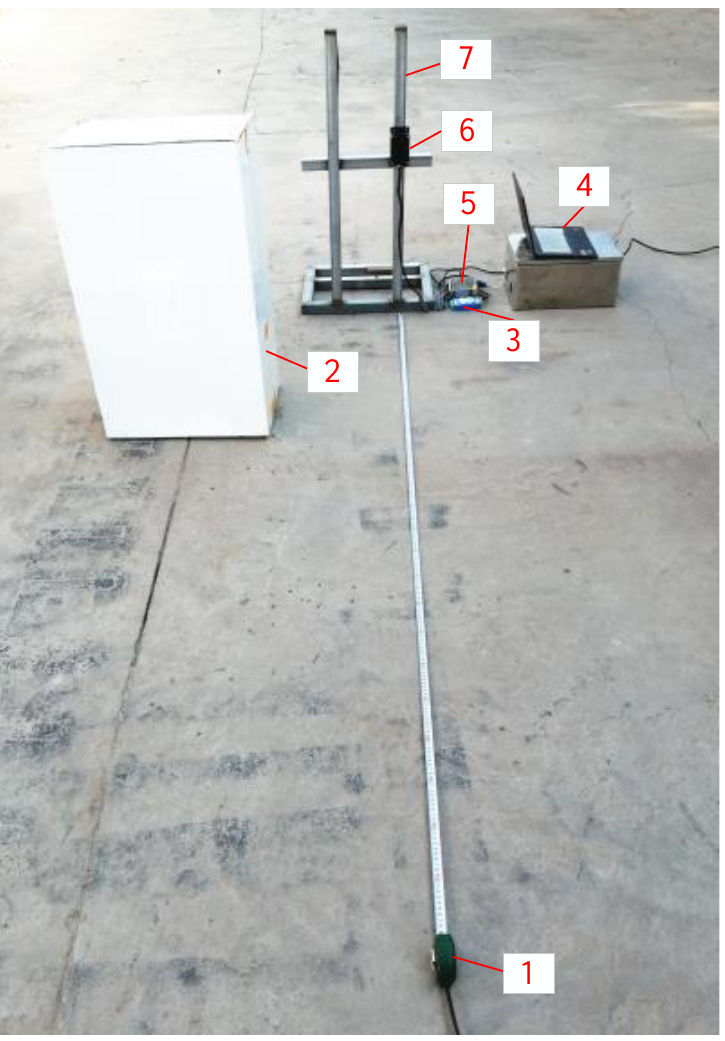
Figure 2. LiDAR sensor check experiment: 1. Tape measure; 2. Paper box 3. Current signal acquisition card; 4. Laptop computer; 5. Power source; 6. LiDAR sensor 7. Fixation frame.